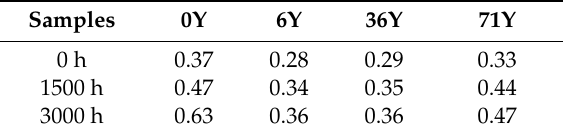
Figure 4. TEM images of the microstructure of CLAM steels: ( a – d ) 0 h, ( e – h ) 1500 h, ( i – l ) 3000 h, ( a , e , i ) 0Y, ( b , f , j ) 6Y, ( c , g , k ) 36Y, and ( d , h , l ) 71Y. Table 3. Width of the martensite lath in steels aged for di ff erent durations ( µ m).